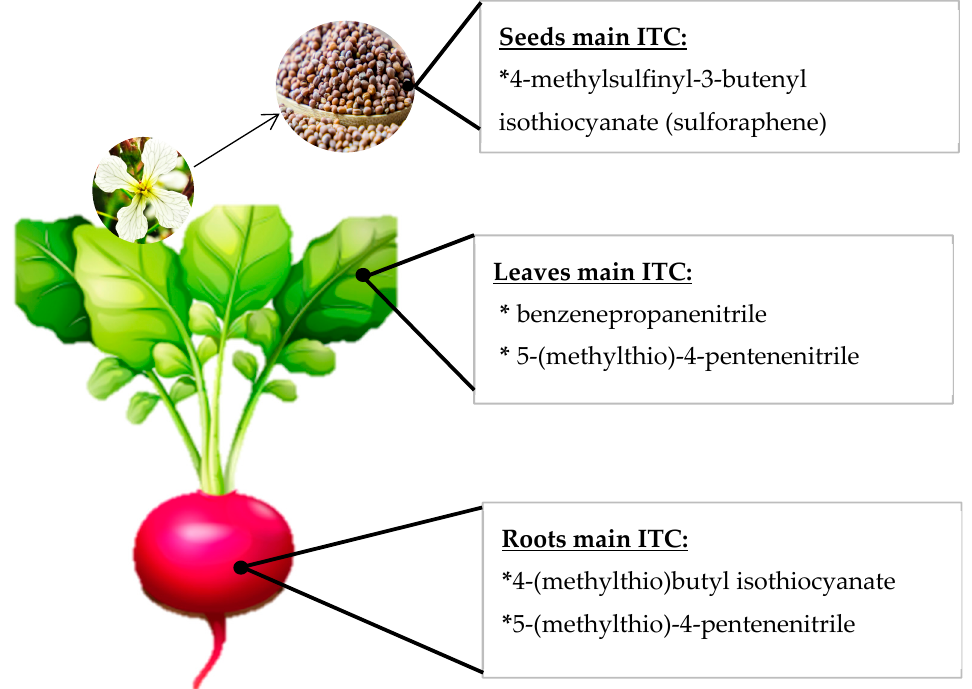
Figure2. Figure 2. Schematic representation of different isothiocyanate (ITC) profiles in several radish plant organs.